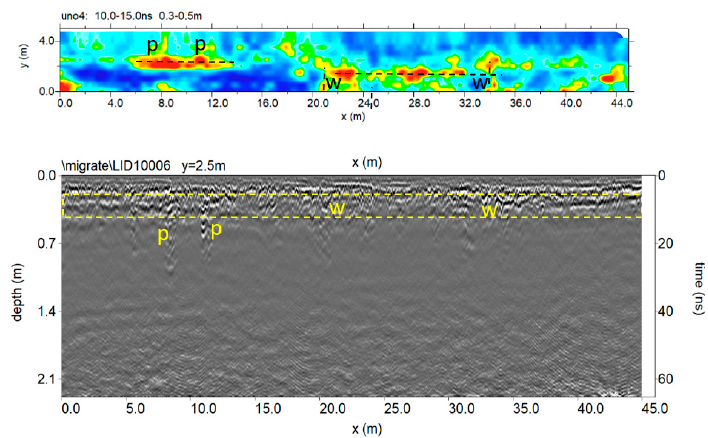
Figure 12. The 600 MHz processed radar section and time slice. Figure 13. show the three-dimensional amplitude isosurface using the 50% threshold.